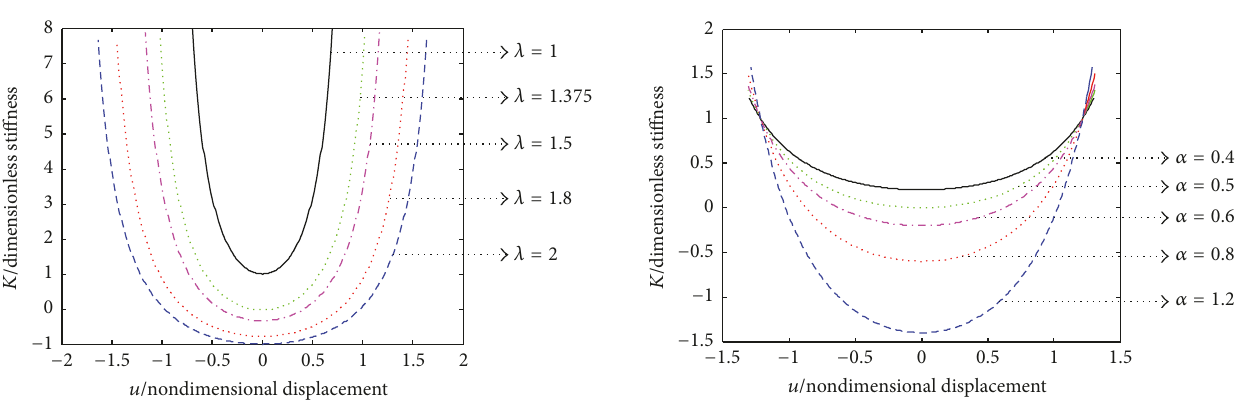
Figure 5: Stiffness curves under different 𝜆 values. Figure 6: Stiffness curves under different stiffness